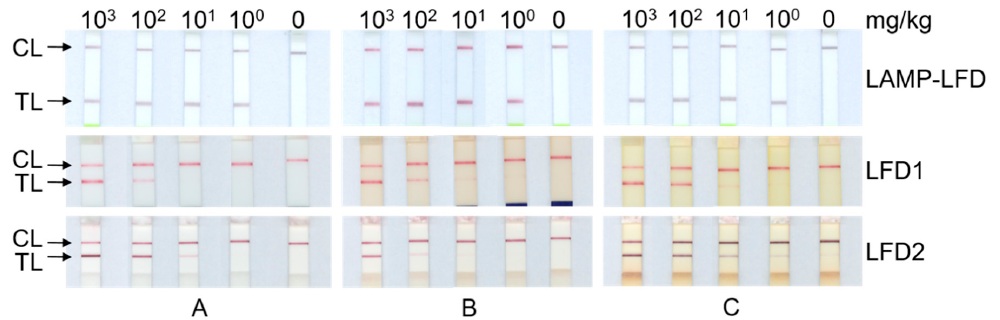
Figure 2. Comparison of test results of ORF160b LAMP-LFD, and both commercial protein-based LFD, of various levels of incurred soybean in matrix: ( A ) sausage; ( B ) chocolate; ( C ) tomato soup matrix. Digital recording of developed test strips resulted in final incubation times that exceeded the manufacturers’ recommendations, and partly led to unspecific detection of protein-based LFD. (CL: control line; TL: test line).